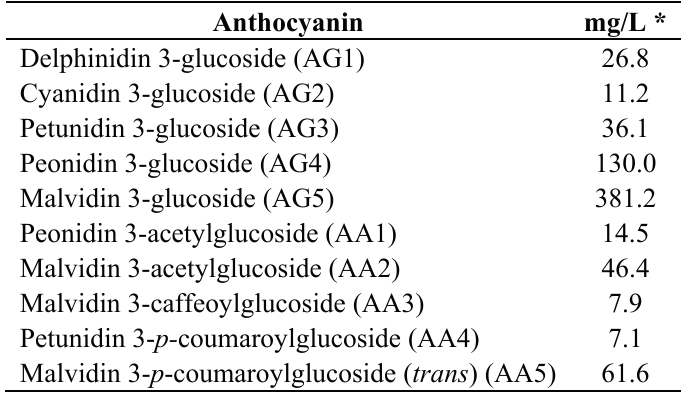
Table 1. Amounts of anthocyanins in the standardized